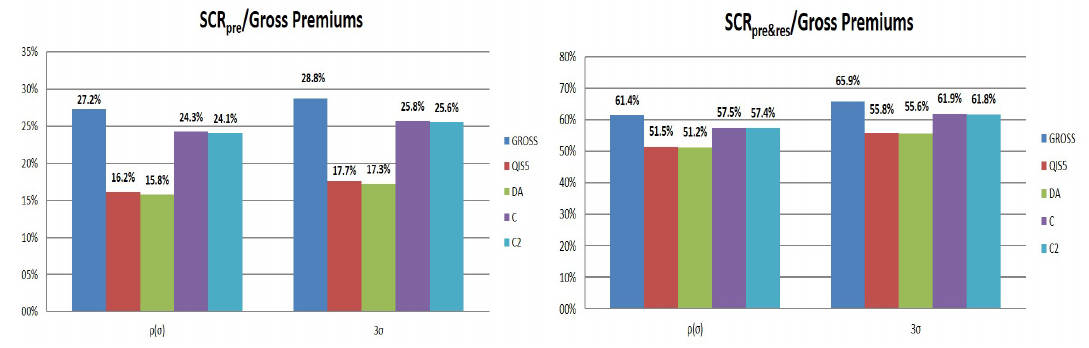
Figure 2. Ratios between SCR and initial gross premiums.